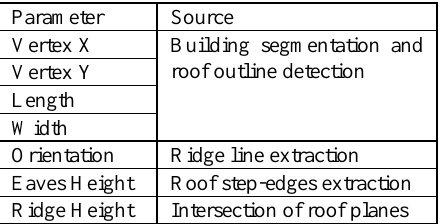
Table 1. Uncertainty sources in building parameters